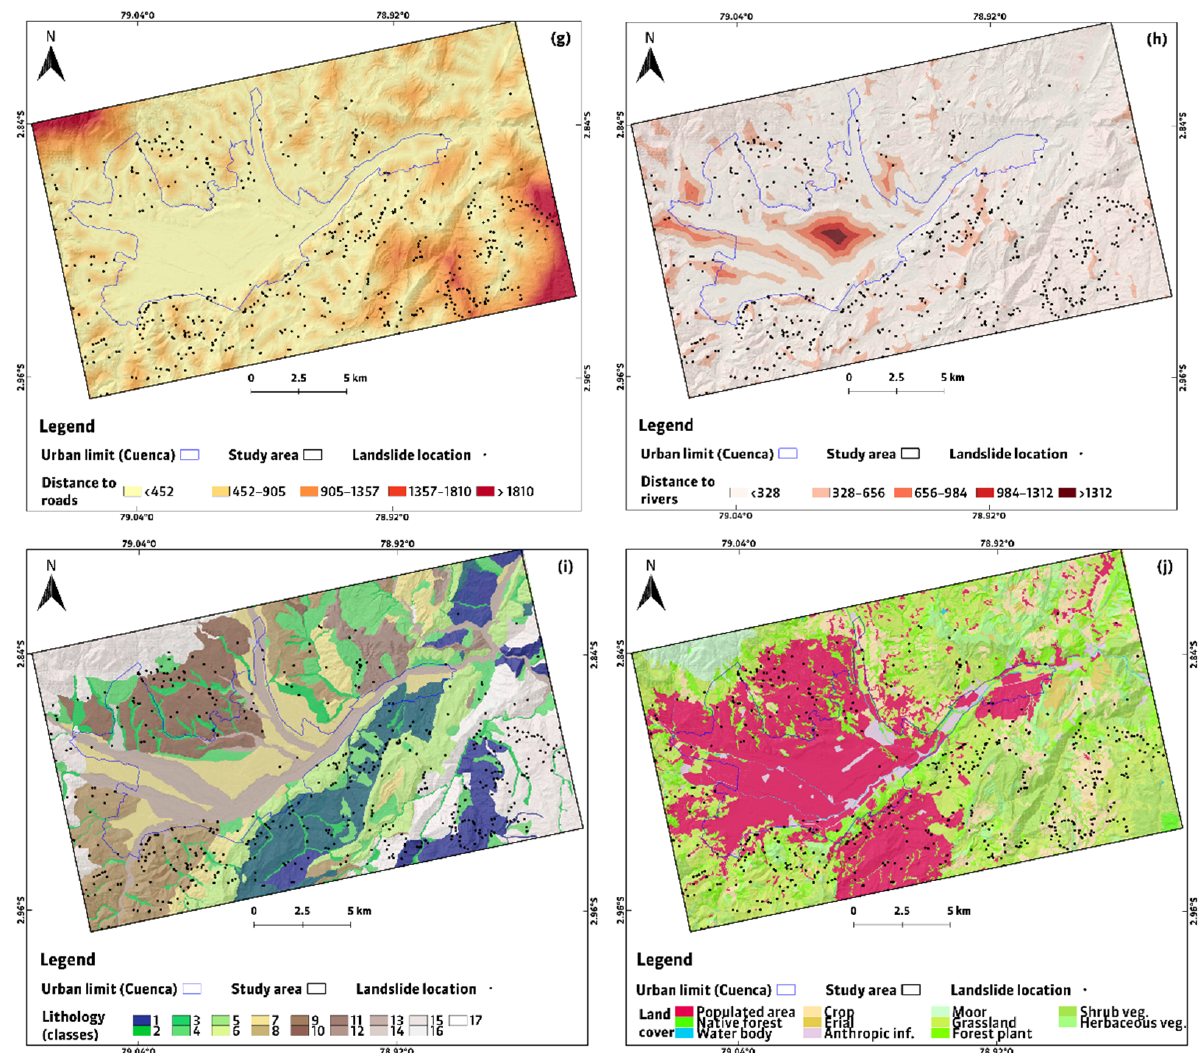
Figure 4. Conditioning factors maps of the study zone: ( a ) elevation, ( b ) slope, ( c ) aspect, ( d ) SPI, ( e ) TWI, ( f ) curvature, ( g ) distance to roads, ( h ) distance to rivers, ( i ) lithology (lithology classes: 1—sandy clays; 2—light laminated shales with gypsum; 3—silts, clays, sands, gravels, and blocks; 4—heterogeneous mixture of fine materials and fine angular fragments without stratification; 5—heterogeneous mixture of fine materials and fine angular fragments (various sizes); 6—medium to coarse-grained tobaceous sandstones; 7—siltstones, shales, and fine-grained sandstones; 8—sandy silt, silty clay; 9—coarse andesitic conglomerates; 10—silts and clays; 11—red clays with sandstones and conglomerates alternation; 12—volcanic agglomerate; 13—sands, silts, clays, and conglomerates; 14—laminated mudstones, dark tobaceous sandstones; 15—variable proportion of silts, clays, sands, gravels, and blocks; 16—kaolinized tuffs and agglomerates; 17—massive siltstones), and ( j ) land cover. Table 2. Conditioning factors considered in this research.